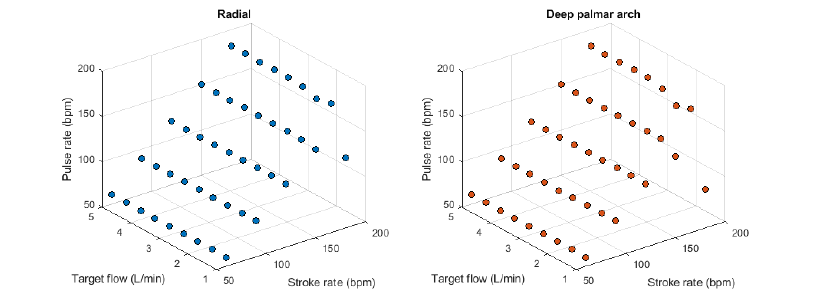
Figure 5. Behaviour of pulse rate measured from the radial ( left ) and deep palmar arch ( right ) phantoms using photoplethysmographic sensors while changing stroke rate and target